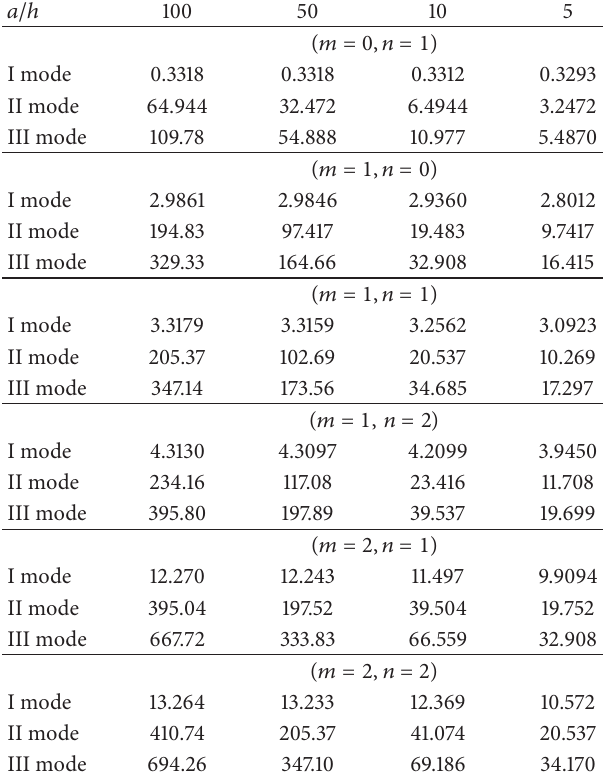
Table 7: Benchmark 3. Simply supported isotropic rectangular plate. First three vibration modes in terms of no-dimensional circular frequency 𝜔 = 𝜔(𝑎 2 /ℎ)√𝜌/𝐸 for several combinations of half-wave numbers 𝑚 and 𝑛 . 𝑀 = 1 fictitious layers and 𝑁 = 18 order of expansion for the exponential matrix.